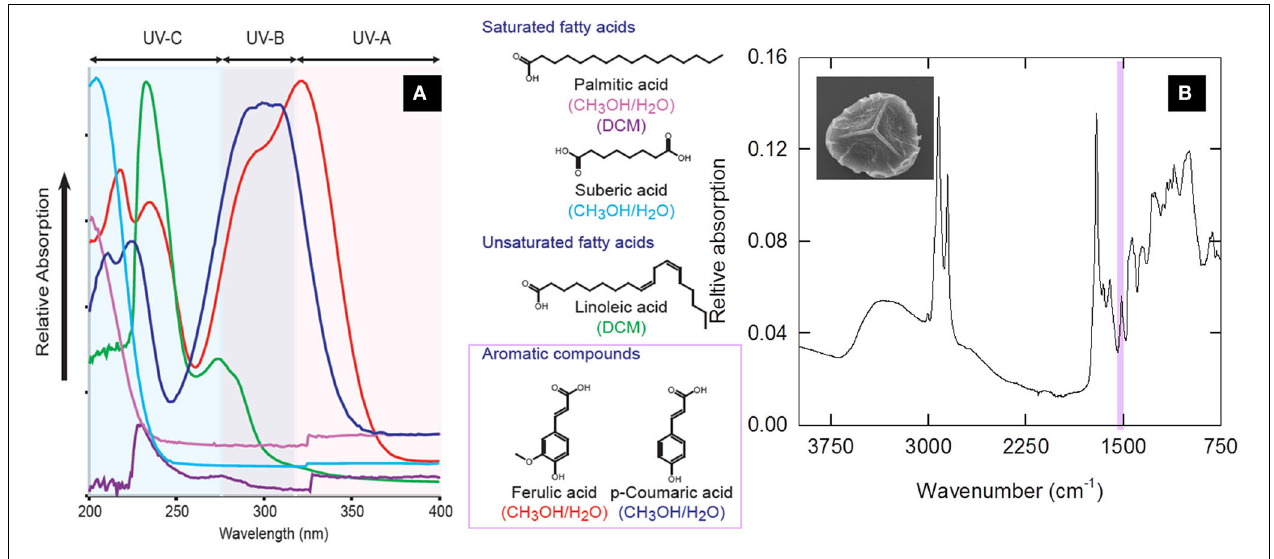
FIGURE 1 | (A) Relative UV-B absorption of chemical standards thought to be constituents of sporopollenin (adapted from Fraser et al., 2011) (B) FTIR trace generated from a Lycopodium clavatum spore; inset,